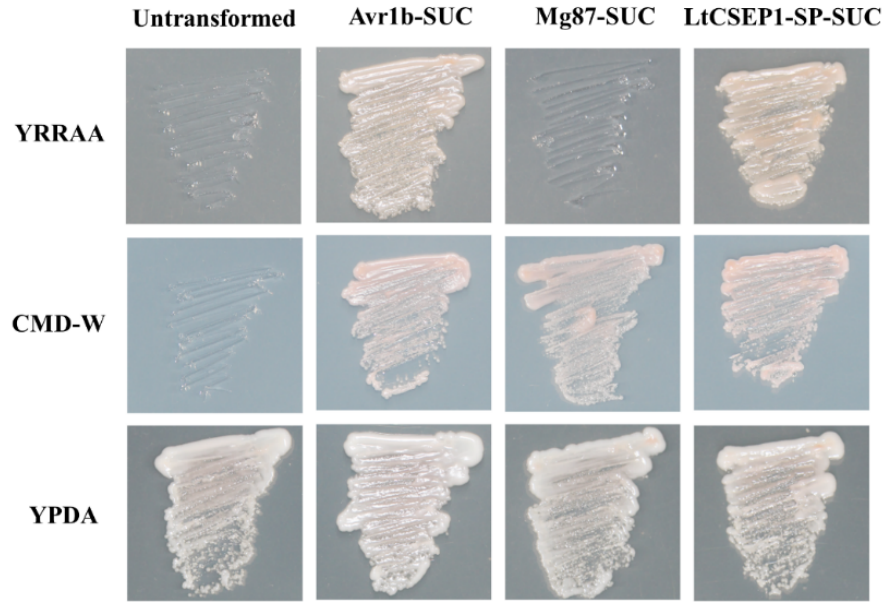
Figure 2. Functional validation of the putative signal peptide of LtCSEP1 using the yeast invertase secretion assay. The putative signal peptide sequence of LtCSEP1 was fused in-frame to the invertase gene in the pSUC2 plasmid and transformed into yeast YTK12 strain. The signal peptide of secreted effector Avr1b from Phytophthora sojae and the first 25 amino acids of the non-secreted Mg87 protein from Magnaporthe oryzae were used as positive and negative controls, respectively.